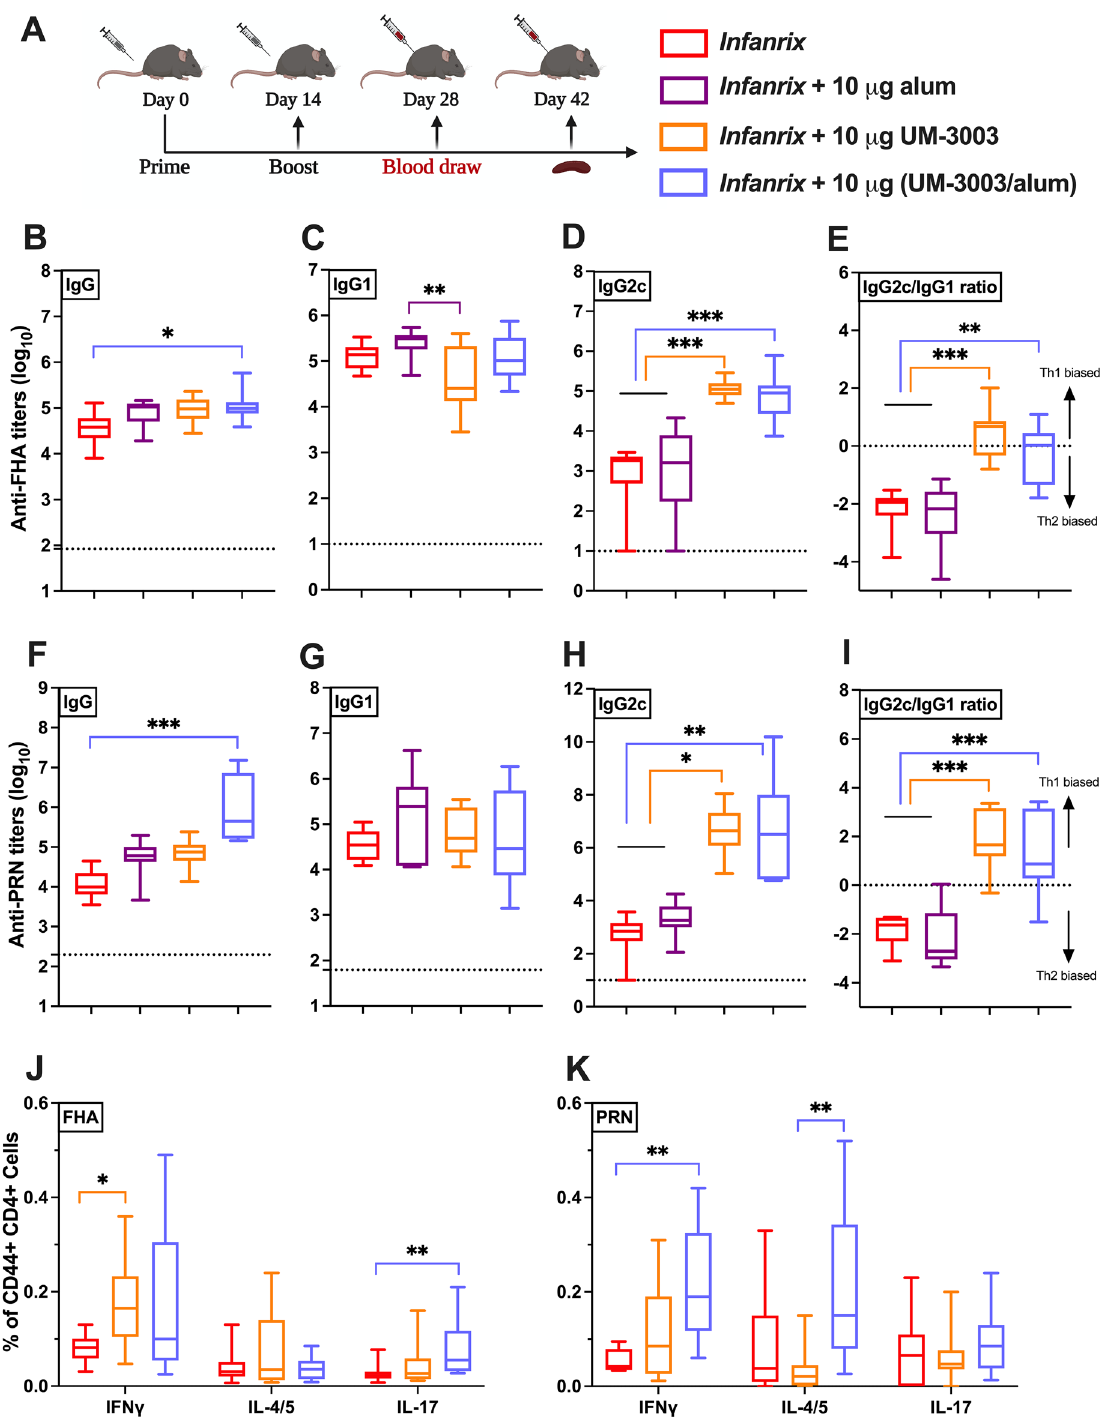
Figure 4. UM-3003 enhances DTaP specific IgG2c production and Th1 polarization in adult mice. Adult C57BL/6 mice were immunized twice, 14 days apart ( A ) with DTaP (1/100th of the human dose) ± UM-3003 or alum at 10 µg per mouse in different formulations (aqueous or pre-adsorbed to alum). Serum was harvested 14 days following boost ( B – I ). Anti-FHA ( B - E ) and anti-PRN ( F – I ) serum Ab IgG ( B , F ), IgG1 ( C , G ) and IgG2c ( D , H ) titers were measured by ELISA. PBS control groups were represented as dotted line. ( E , I ) IgG2c/IgG1 ratios for FHA and PRN respectively. ( J , K ) Murine CD4 + T cell responses after FHA and PRN stimulation. Four weeks following booster, splenocytes from DTaP and adjuvanted vaccinates were isolated, stimulated with 2 μg/ml of either FHA or PRN along with CD28 (1 μg/ ml) and CD49d (1 μg/ml) for 12 h followed by 6 h of BFA stimulation to block the extracellular cytokine secretion. After stimulation, cells were harvested, stained (intracellular cytokine staining) and analyzed by flow cytometry. Plots were gated on CD44 + CD4 + lymphocytes and analyzed for all combinations of simultaneous IFNγ, IL-4/5 and IL-17A productivity. Statistical analysis was performed by nonparametric Kruskal–Wallis test corrected for multiple comparisons; * p < 0.033, ** p < 0.002, *** p < 0.001 (n = 8–15 per group). Study is inclusive of three independent